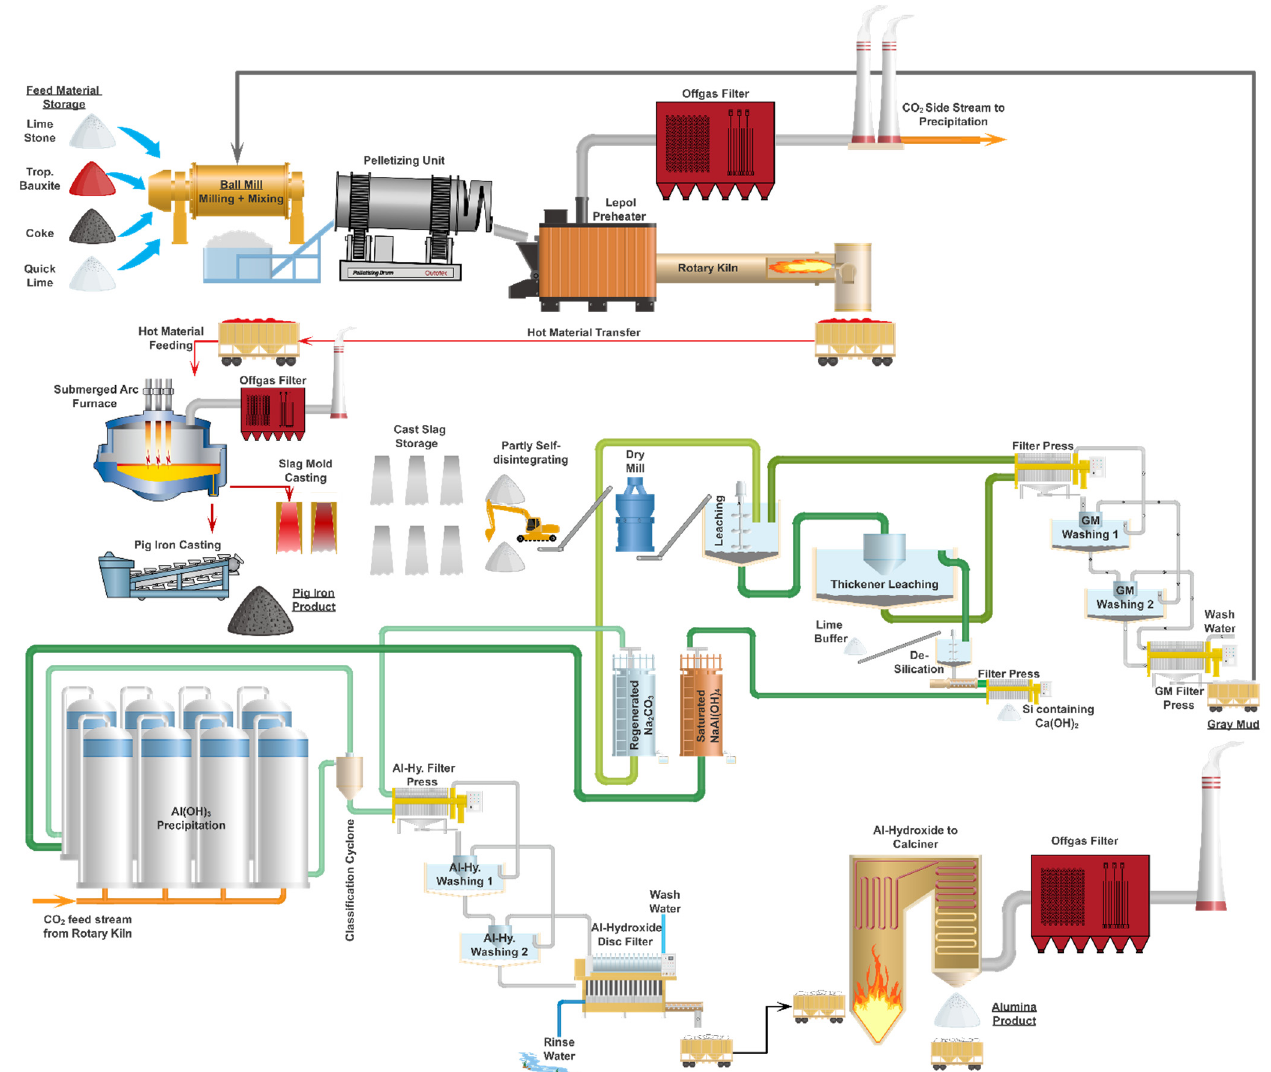
Figure 3. Illustrated process concept of the reengineered Pedersen Process.